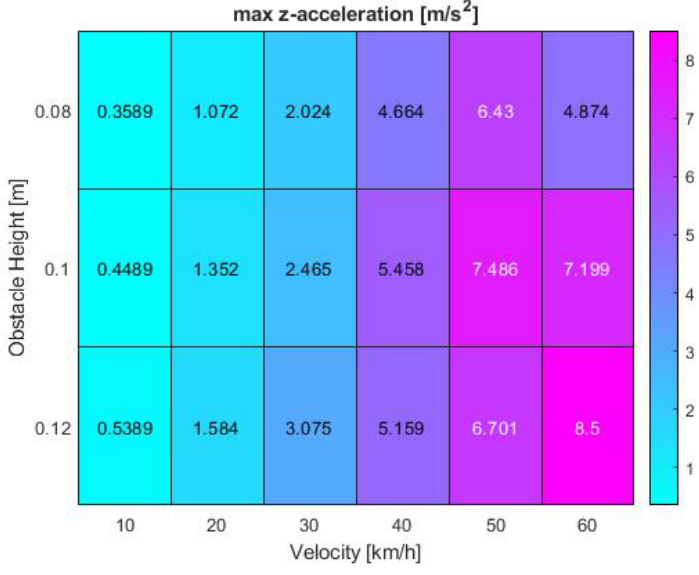
Figure 11. Vehicle z -acceleration at various bump obstacle heights and vehicle velocities in the